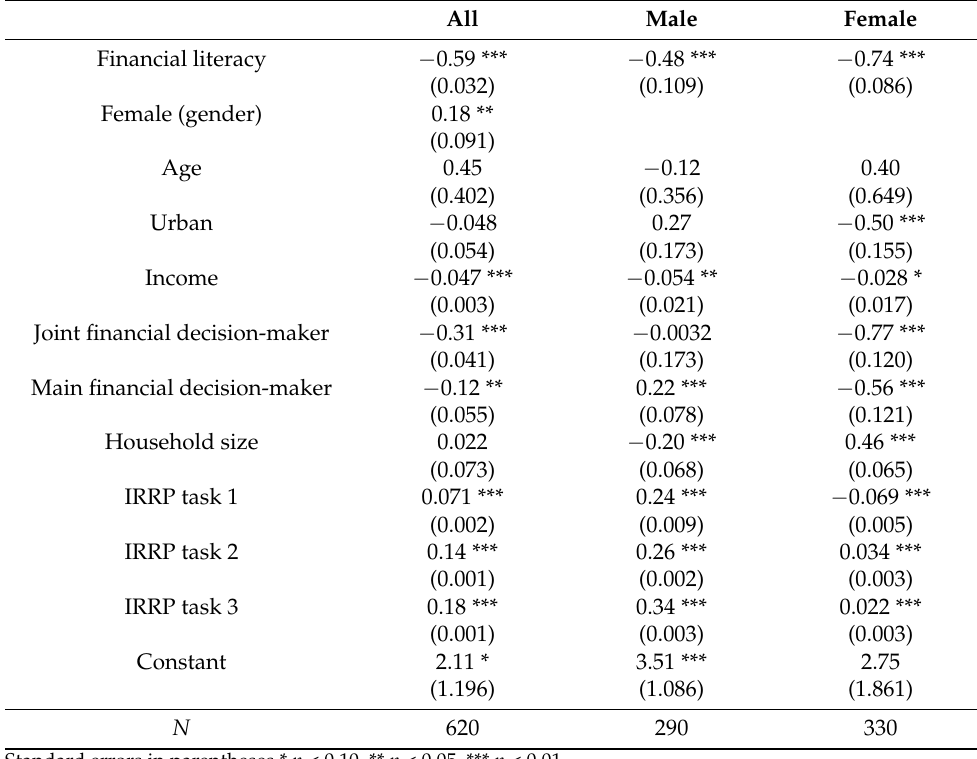
Table 6. RE panel regression: dependent variable risk